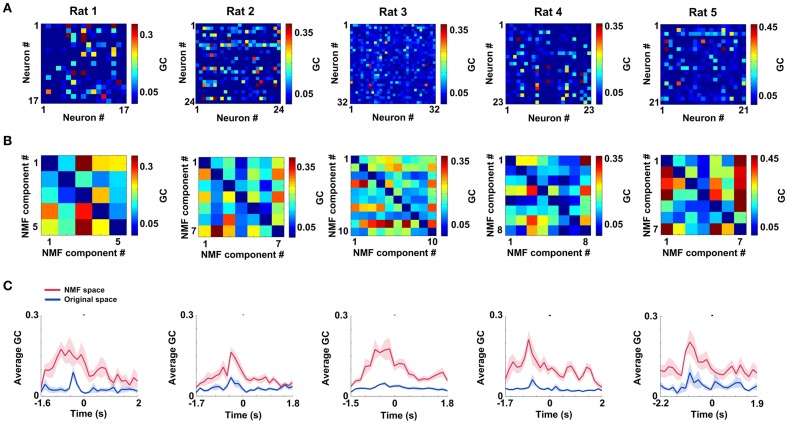
mPFC spike networks during WM in original and NMF spaces. (A) Mean connectivity matrices during WM for 5 rats in original space (nRat1 = 20 trials, nRat 2 = 13 trials, nRat 3 = 18 trials, nRat 4 = 27 trials, nRat5 = 18 trials). Each node represents a neuron. Colored grid represents the Granger causality between each pair of neurons. The hot colors show strong connections and the cold ones show weak connections. (B) Mean connection matrices in NMF space (nRat 1 = 20 trials, nRat 2 = 13 trials, nRat 3 = 18 trials, nRat 4 = 27 trials, nRat 5 = 18 trials). Each node represents a NMF component. Colored grid represents the Granger causality between each pair of NMF components. The grids are coded according to the connection weight. (C) Average Granger causality weights as a function of time in correct trials for 5 rats (red: NMF space, blue: original space; nRat 1 = 20 trials, nRat 2 = 13 trials, nRat 3 = 18 trials, nRat 4 = 27 trials, nRat 5 = 18 trials).